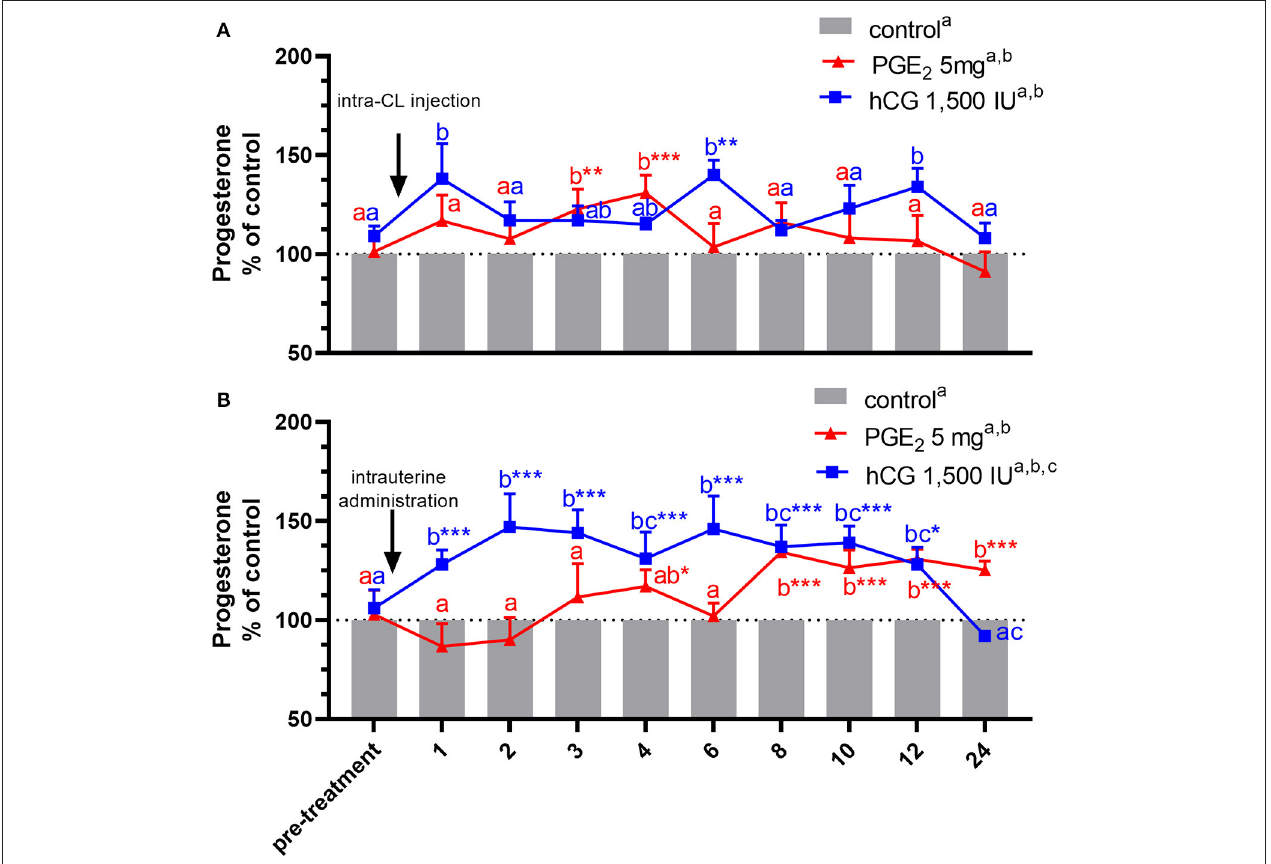
FIGURE 3 | Concentrations of progesterone (P 4 ) in the jugular vein blood plasma in mares with one (A) intra-CL injection of saline (control; gray bar), prostaglandin (PG) E 2 (PGE 2 ; 5 mg/ml; red line), or human chorionic gonadotropin (hCG, positive control; 1,500 IU/ml, blue line) or (B) one intrauterine administration of saline (control; gray bar), PGE 2 (5 mg/5ml; red line), or hCG (positive control; 1,500 IU/5ml, blue line) on day 10 of the estrous cycle. All values were presented as % of the control. Different superscript letters a,b,c indicate significant differences between blood P 4 level in PGE 2 - or hCG-treated groups of mares vs. control group at specific time points of blood sample collection. Asterisks indicate significant differences in blood P 4 level within PGE 2 - or hCG-treated group of mares vs. average concentration of P 4 in blood plasma in the period before treatment (pre-treatment time: − 2 to 0h). Average concentrations of P 4 in the blood plasma samples of control mares during the period before treatment (pre-treatment time) were (A) 10.92ng/ml or (B) 11.15ng/ml, respectively. The results were considered significantly different at p <